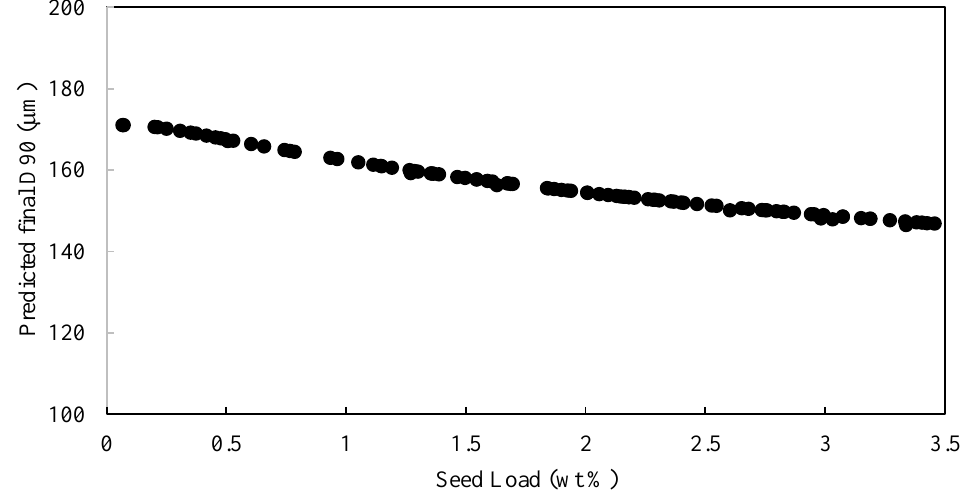
Figure 4. Predicted impact of seed load on final D90 was not significant, and, therefore, this process parameter was not further investigated experimentally.